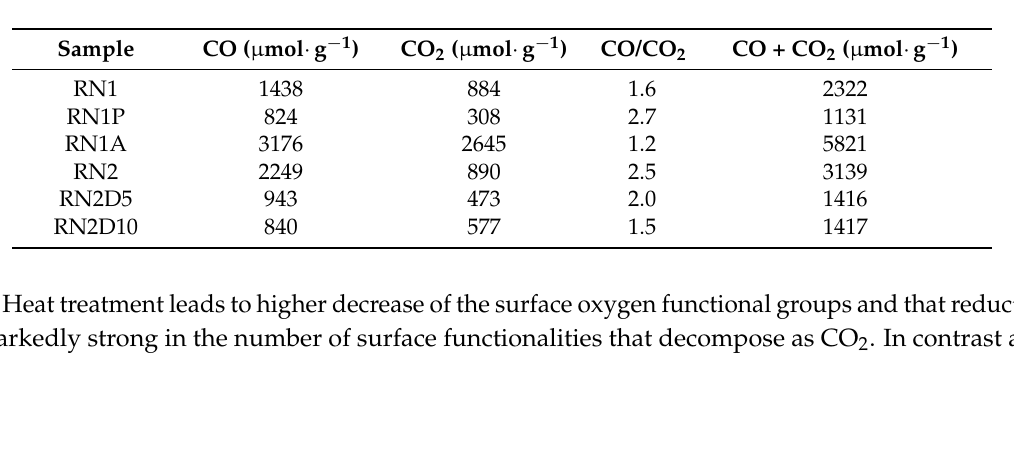
Table 2. Textural parameters of the samples obtained from the N2 and CO2 adsorption isotherms the values corresponding to W 0 and E 0 obtained from the CO 2 adsorption isotherms are within the ranges described above, showing a good development of the narrow microporosity. It is also interesting to note the importance of both micropore volume and micropore size distribution on the CO 2 uptake.